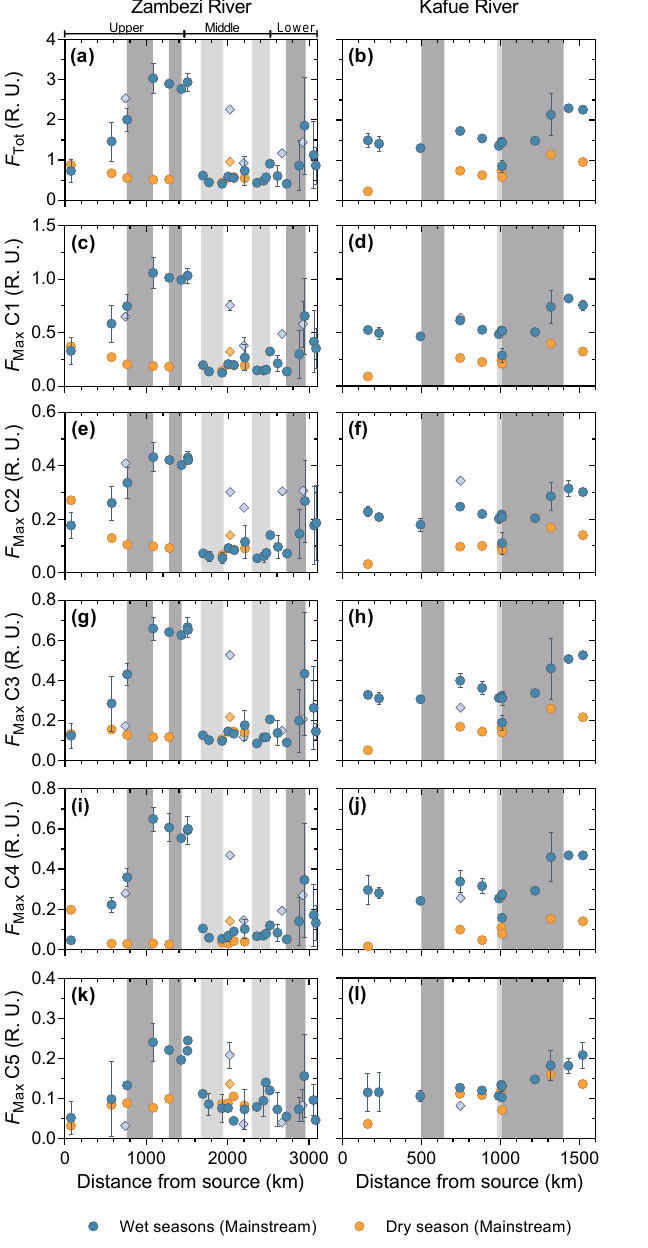
Figure 5. Longitudinal variations in FDOM along the Zambezi River (left panels) and the Kafue River (right panels) during the wet and the dry seasons. From top to bottom the panels represent: F Tot and F Max for each PARAFAC component. The diamonds represent samples taken from main tributaries upstream of their confluence with mainstreams.